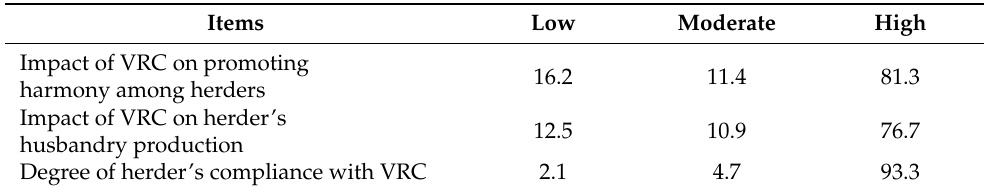
Table 5. Herder’s attitude toward VRC (percent of respondents). Items